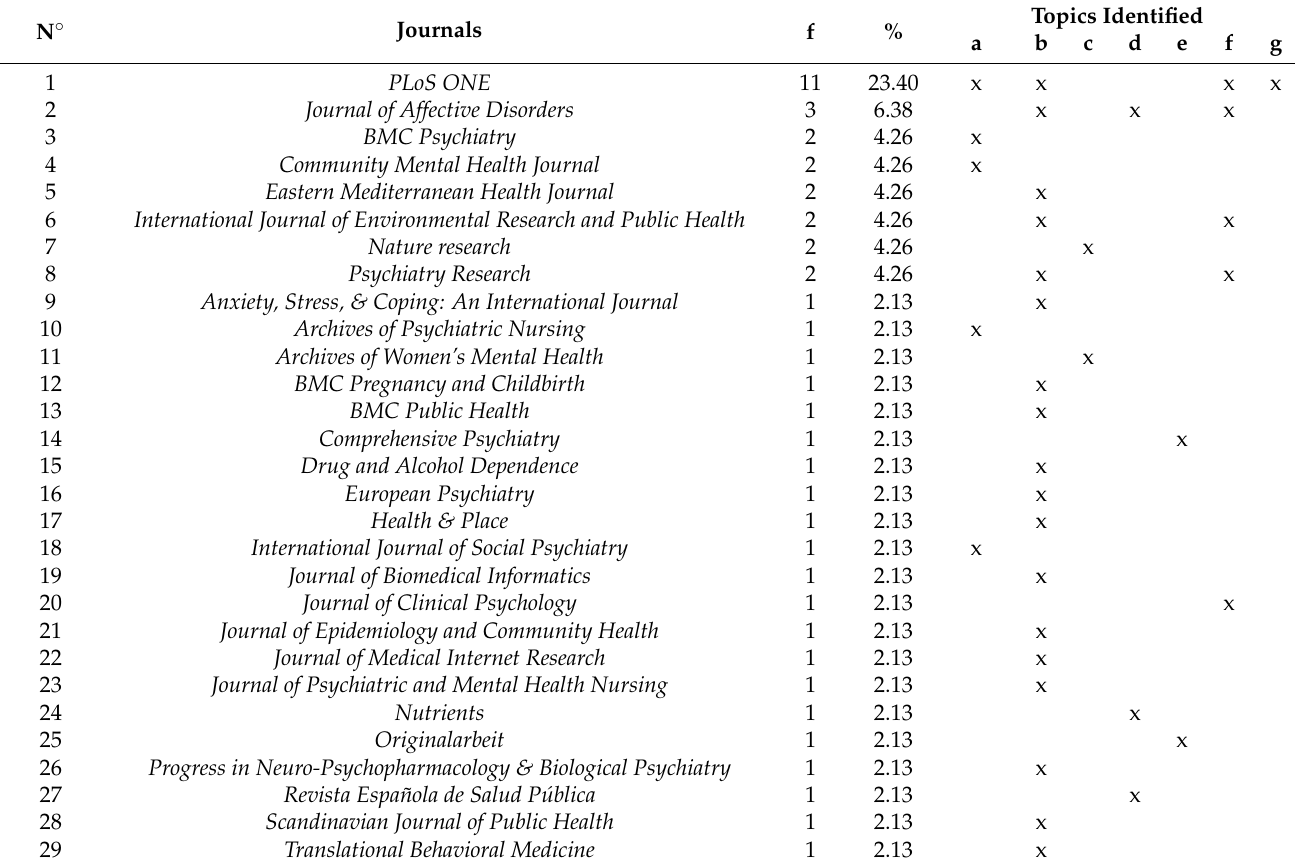
Table 2. Health science journals indexed in PubMed that published original articles on mental health during the pandemic.